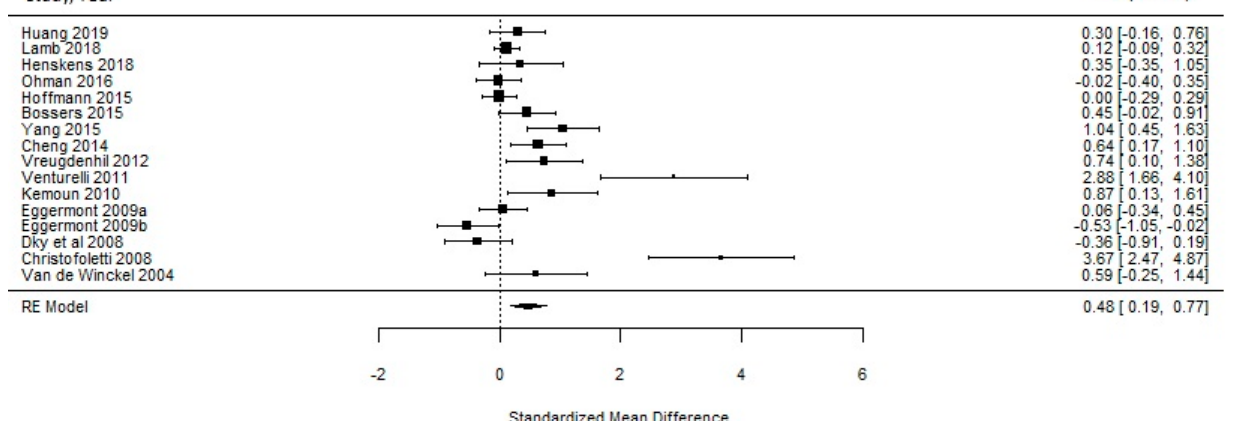
Figure 2. Effects of PA on the cognitive function of PwD.